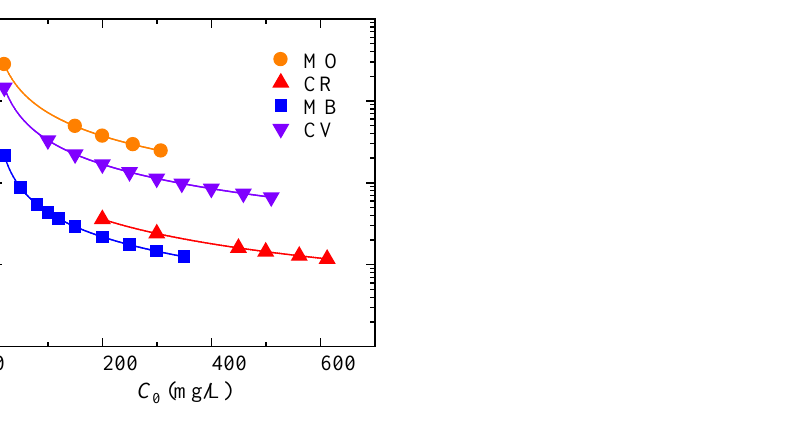
Figure 17. Change in the separation factor of the DA5 sample with initial concentration of anionic (MO and CR) and cationic (MB and CV) dyes (dosage = 0.5 g/L, temperature = 301 K).